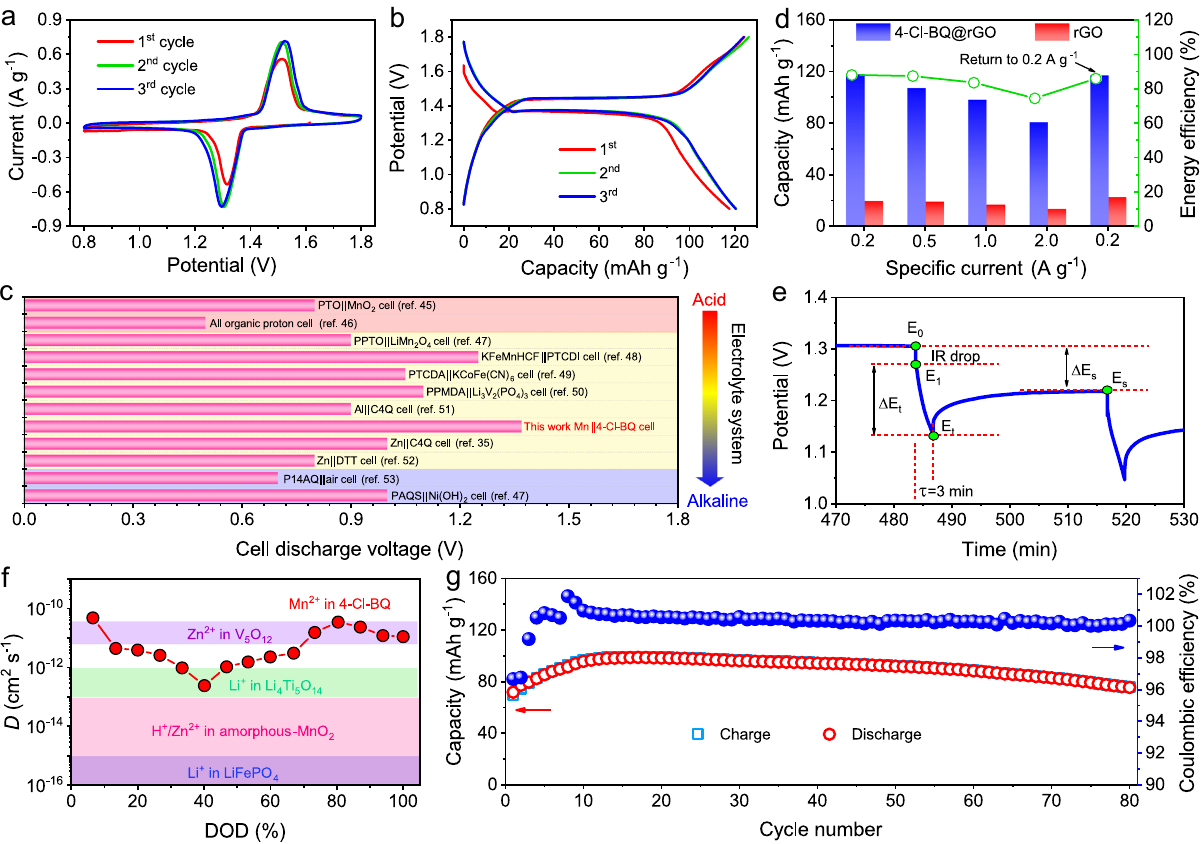
Fig. 4 Electrochemical performance of the Mn||4-Cl-BQ cells. a CV curves at 0.2 mV s − 1 . b GCD curves at 0.2 A g − 1 . c Comparison of the cell discharge voltages between different aqueous quinone-based cells in acid, mild and alkaline electrolytes. d Capacities of rGO and 4-Cl-BQ@rGO composites at different speci fi c currents. The right y -axis is the energy ef fi ciency of Mn||4-Cl-BQ cells. e Selected steps of the GITT curve at 0.2 A g − 1 during discharging, in which the key parameters for diffusion coef fi cient calculation are marked. f The calculated Mn 2 + ion diffusion coef fi cient during discharging and the comparison with other battery systems. g Cycling performance at 1.0 A g − 1